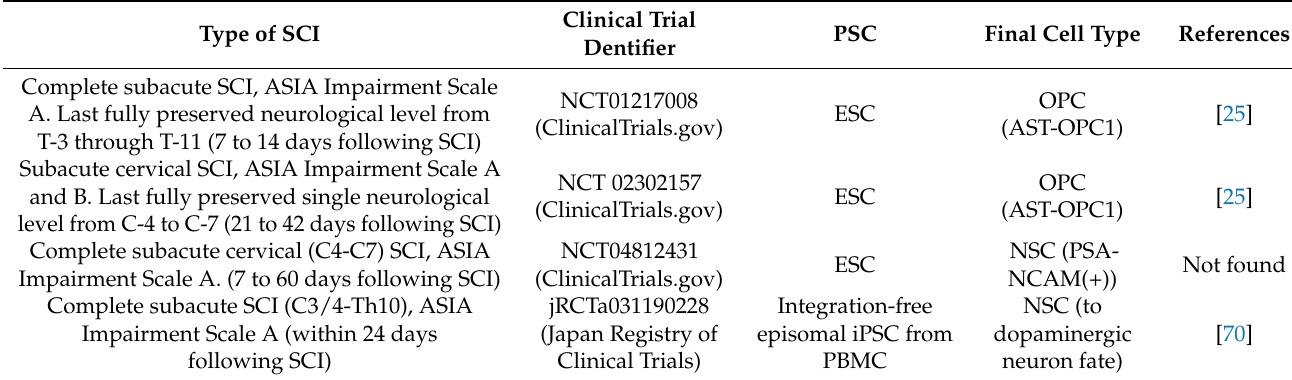
SCI: spinal cord injury; PSC: pluripotent stem cells; ASIA: American Spinal Cord Injury Association; ESC: embryonic stem cells; iPSC- induced pluripotent stem cells; PBMC: peripheral blood mononuclear cells; OPC: oligodendrocyte progenitor cells; NSC: neural stem cells; PSA-NCAM: polysialylated form of neural cell adhesion